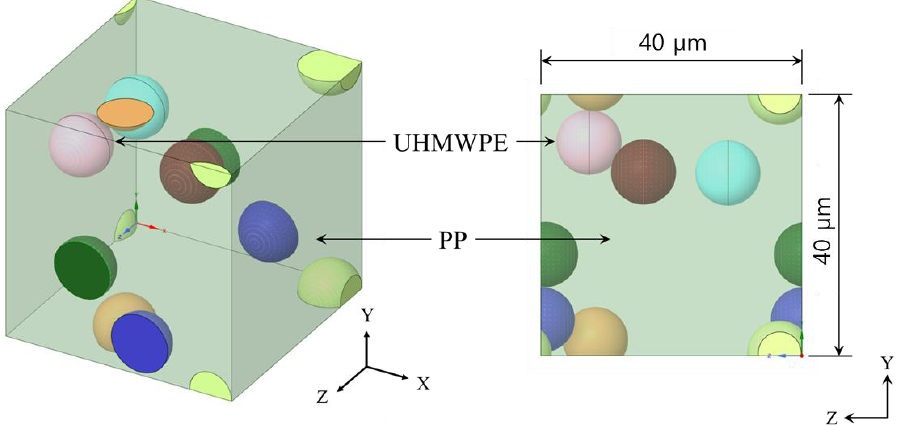
Figure 1. Ultra-high molecular weight polyethylene (UHMWPE) particle-reinforced polypropylene (PP) composite representative volume element modeling.